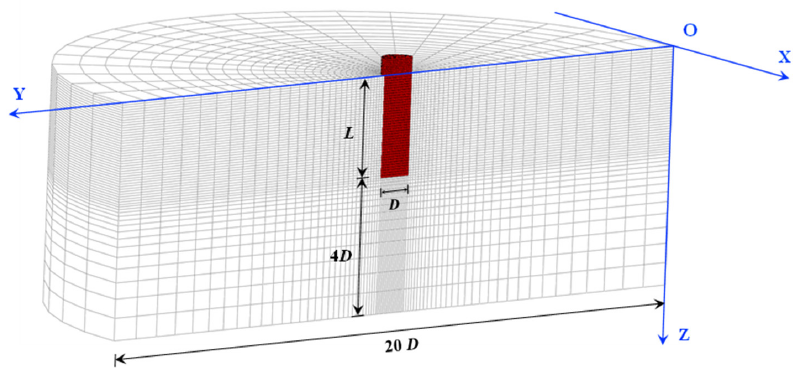
Figure 3. Typical model mesh of monopile with diameter of 10 m under a loading height of 5 m.